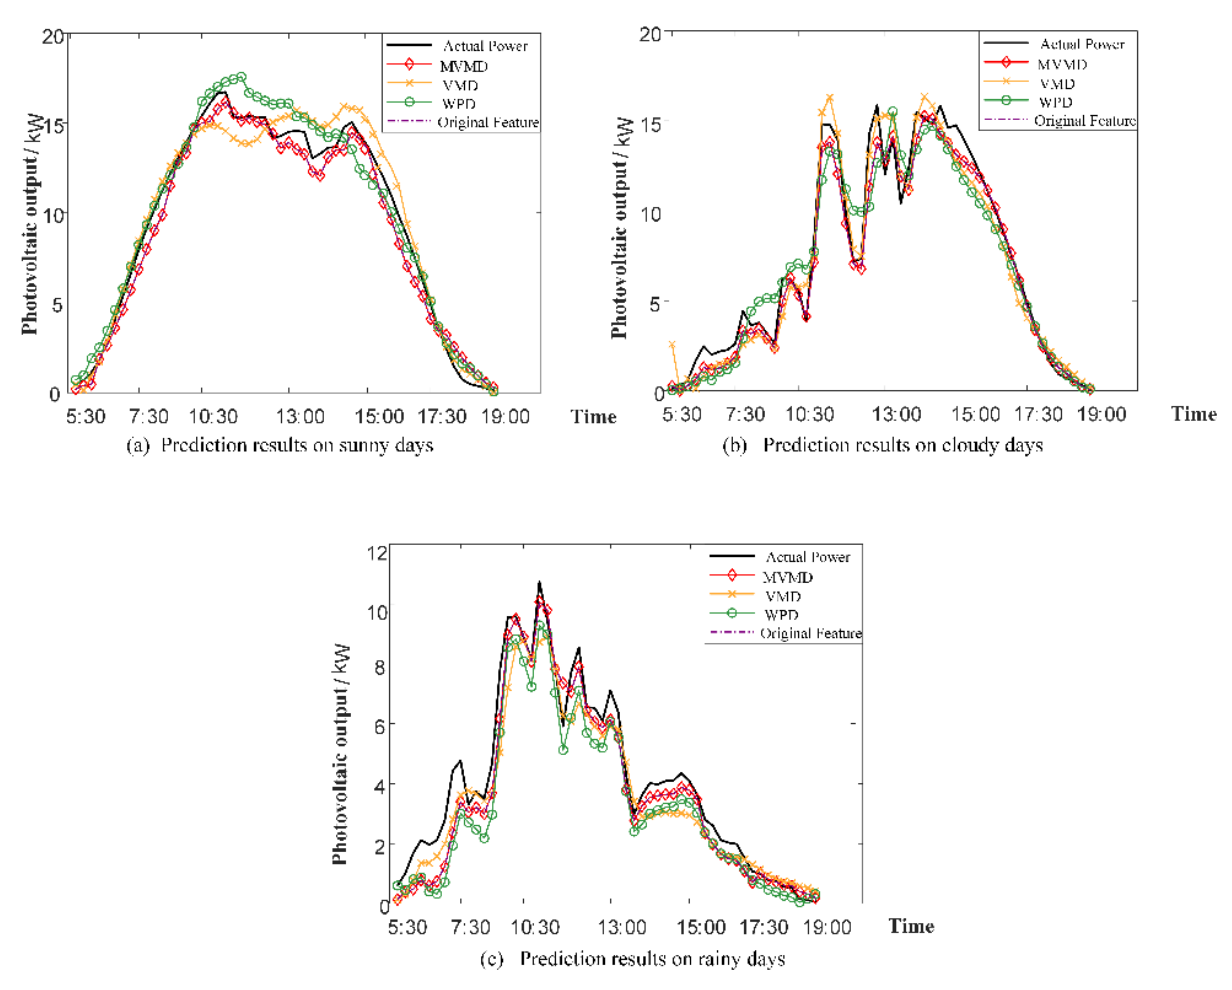
Figure 6. Comparison of each model prediction under different weather conditions.